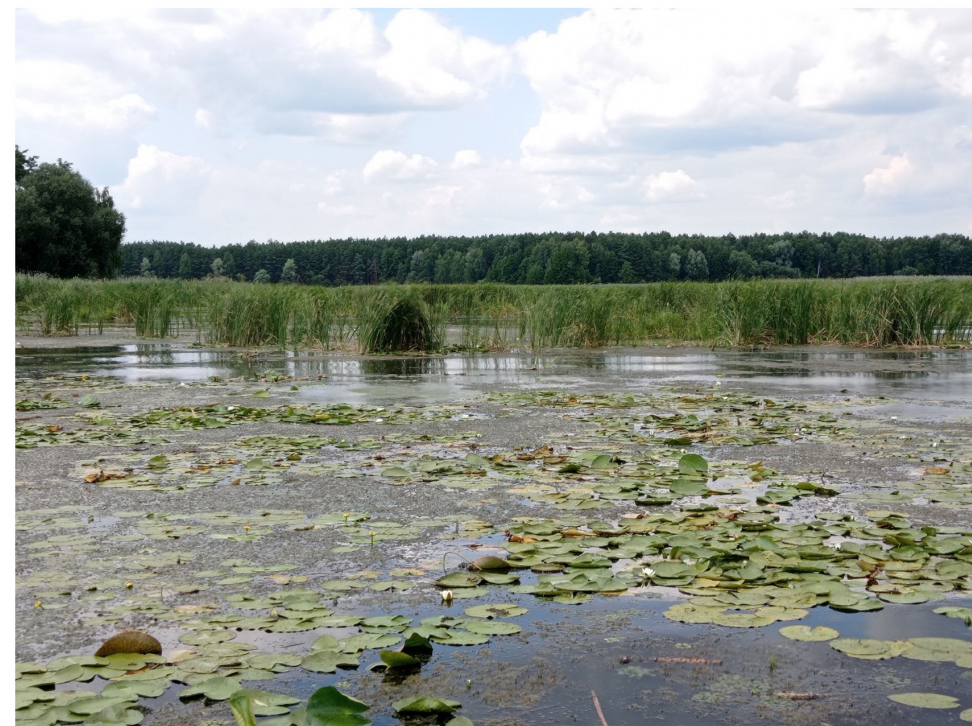
Figure 2. Floating aquatic plants ( Trapa natans L., Nuphar lutea (L.) Smith) in the Kyiv Reservoir (Dnipro River,